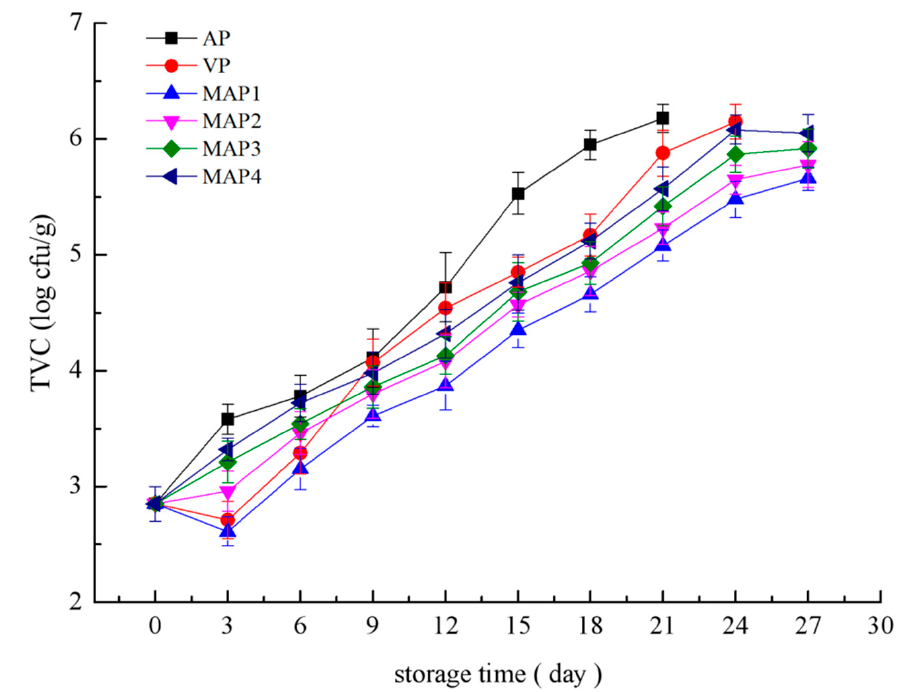
Figure 4. Changes in total viable counts (TVC) of samples under different treatments during storage period (AP: air packing; VP: vacuum packing; MAP1:70% CO 2 / 30% N 2 ; MAP2: 60% CO 2 / 10% O 2 / 30% N 2 ; MAP3: 50% CO 2 / 15% O 2 / 35% N 2 ; MAP4: 55% CO 2 / 5% O 2 / 40% N 2 ).